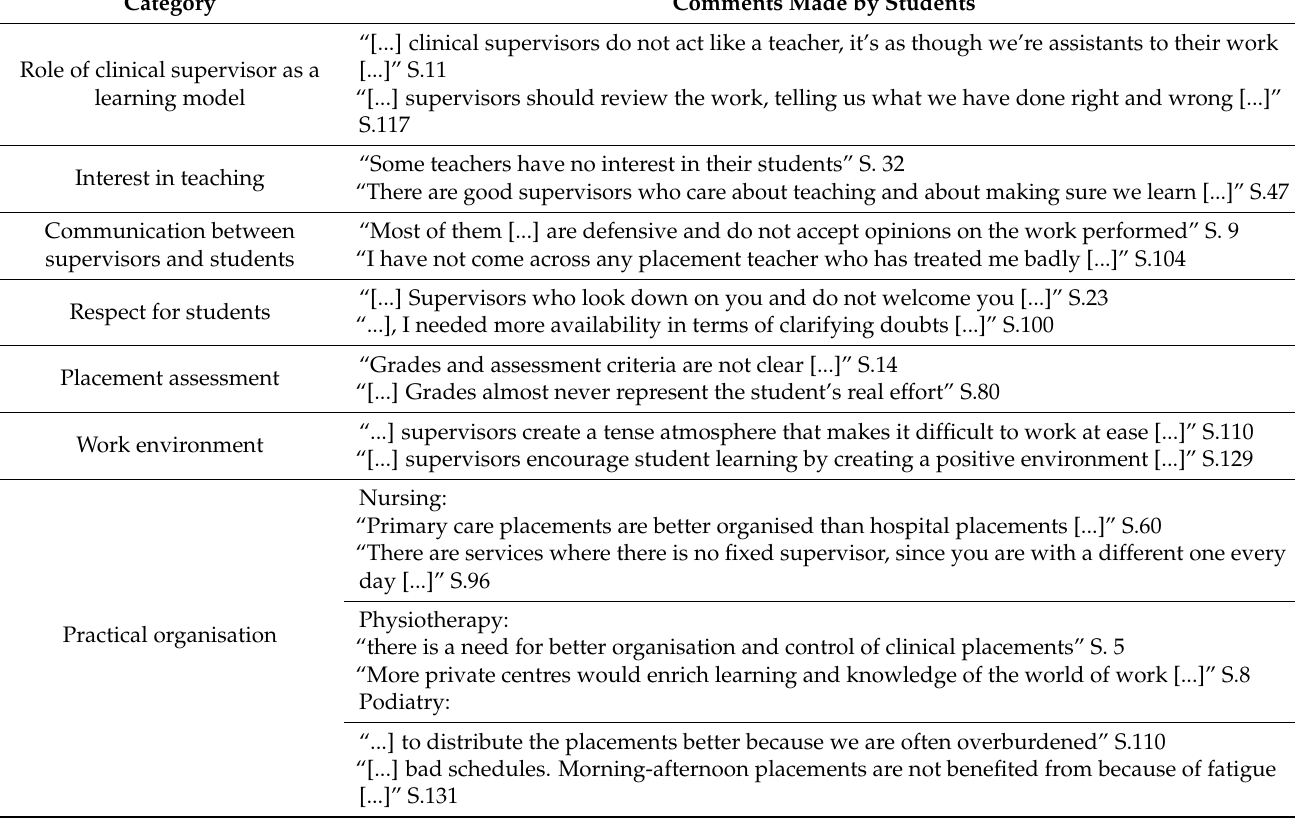
Table 6. Categories obtained after grouping the comments made by the